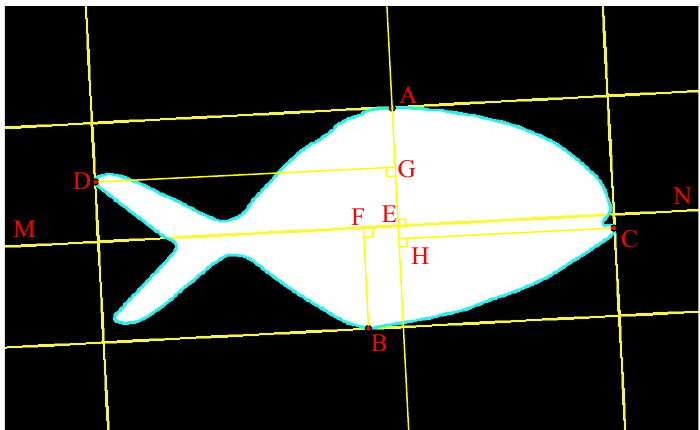
Figure 13. Working diagram of contour detection and line Fig. 8 Working diagram of contour detection and line fitting.